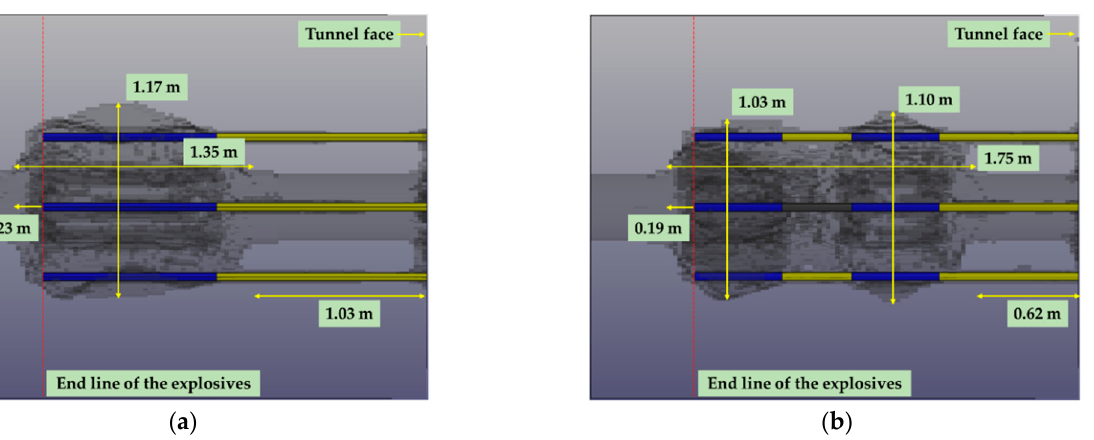
Figure 12. Comparison of the failure patterns of ( a ) the original LLB method and ( b ) the modified LLB method using the deck charge technique.